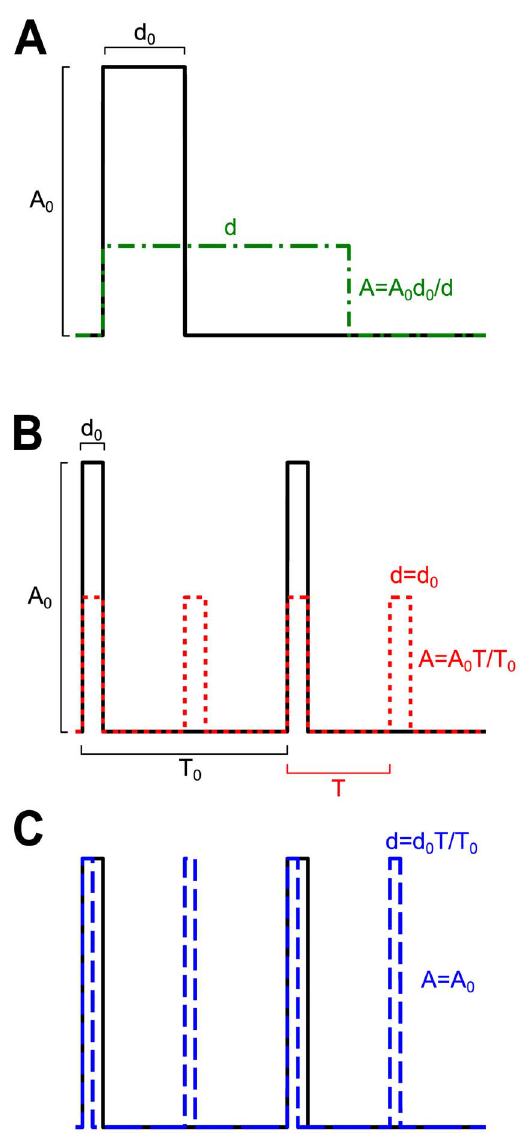
Figure 1. Dose conservation for rectangular pulse signals. ( A ) A pulse that is large and brief (black curve, amplitude A 0 and duration d 0 ) will have the same dose as a small and long pulse (green dash-dotted curve) as long as the new pulse satisfies A=A 0 d 0 /d. ( B ) For periodic signals, the initial signal (black curve) is defined by its amplitude A 0 , duration d 0 , and period T 0 , and its mean dose per period is A 0 d 0 /T 0 . When the pulse period is changed from T 0 to T, the dose can be conserved by changing the amplitude to A=A 0 T/T 0 ( B , dotted red curve) or the duration to d=d 0 T/T 0 ( C , dashed blue curve), such that Ad/T=A 0 d 0 /T 0 . We refer to these as amplitude compensation and duration compensation,